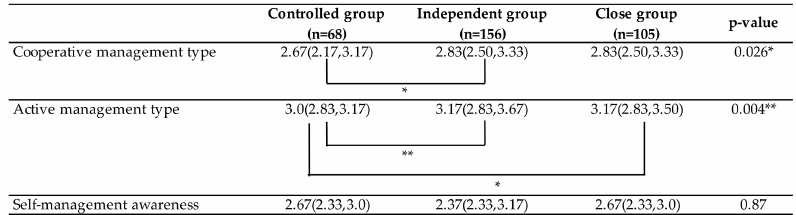
Figure 3. Examination of sexual risk-coping consciousness scores in each mother-daughter relationship cluster ( n = 329). Kruskal-Wallis test and multiple comparison test (Bonferroni correction); The value is the median, and the values in ( ) are the 25th and 75th percentiles; ** p < 0.01 and * p <